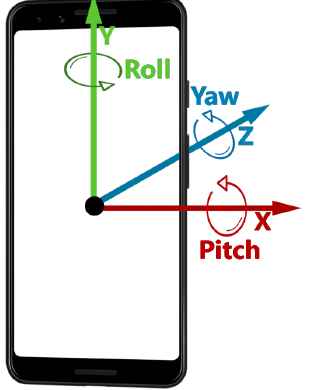
Figure 6. 3DOF of Rotation in a smartphone.